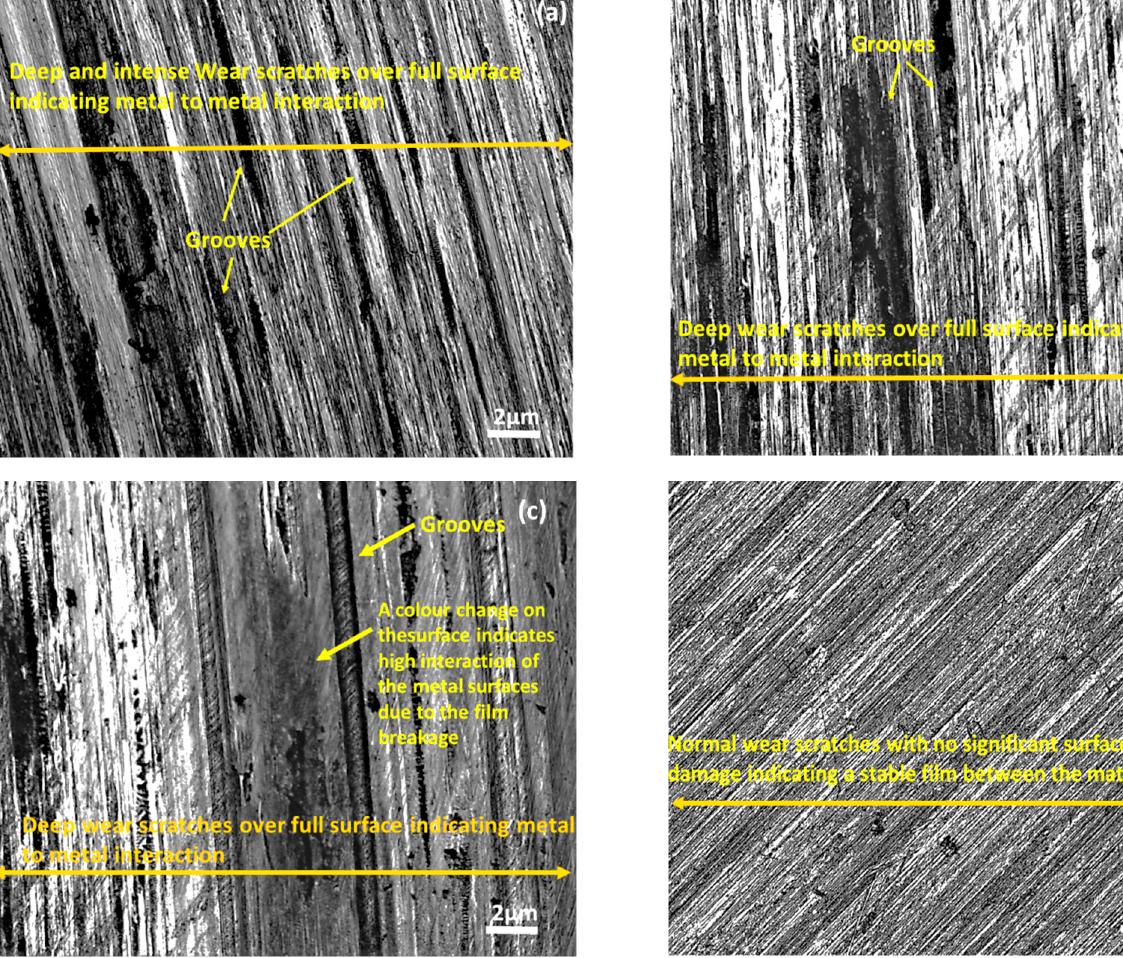
Figure 10. Optical microscope images of the pin at a magnification of 100 × when moving against ( a ) non-textured disc, ( b ) circular grooves—when the pin slides in the direction of the groove, ( c ) perpendicular grooves—when the pin slides against the direction of the grooves, and ( d ) disc with the optimized dimple size.